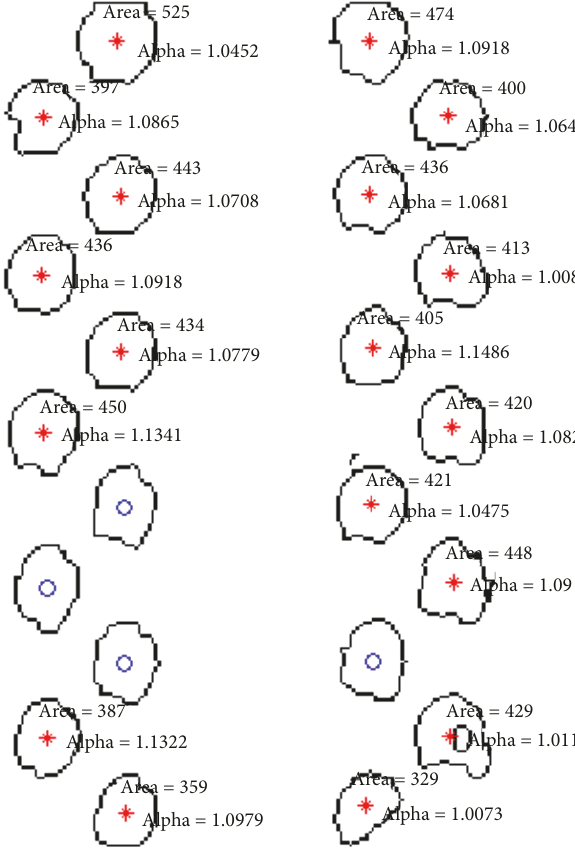
Figure 8: Some defect detection examples. Red “ ∗ ” shows good solder joint and blue “o” indicates the defect